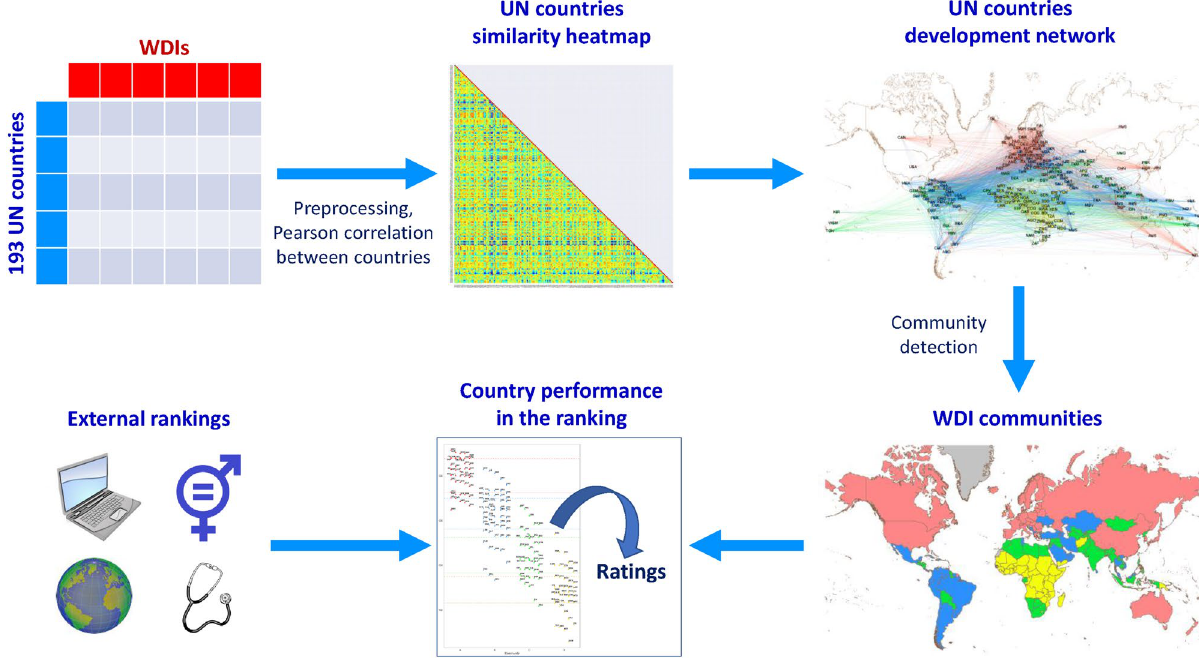
with index rankings with resolution ratio R > 1 , in order to evaluate performances of countries according